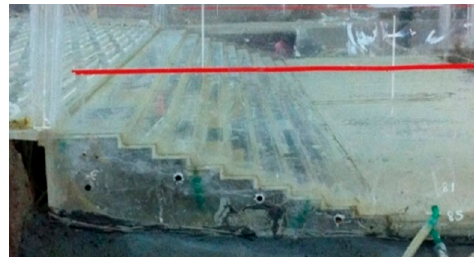
Figure 4. Stepped connecting segment [16].